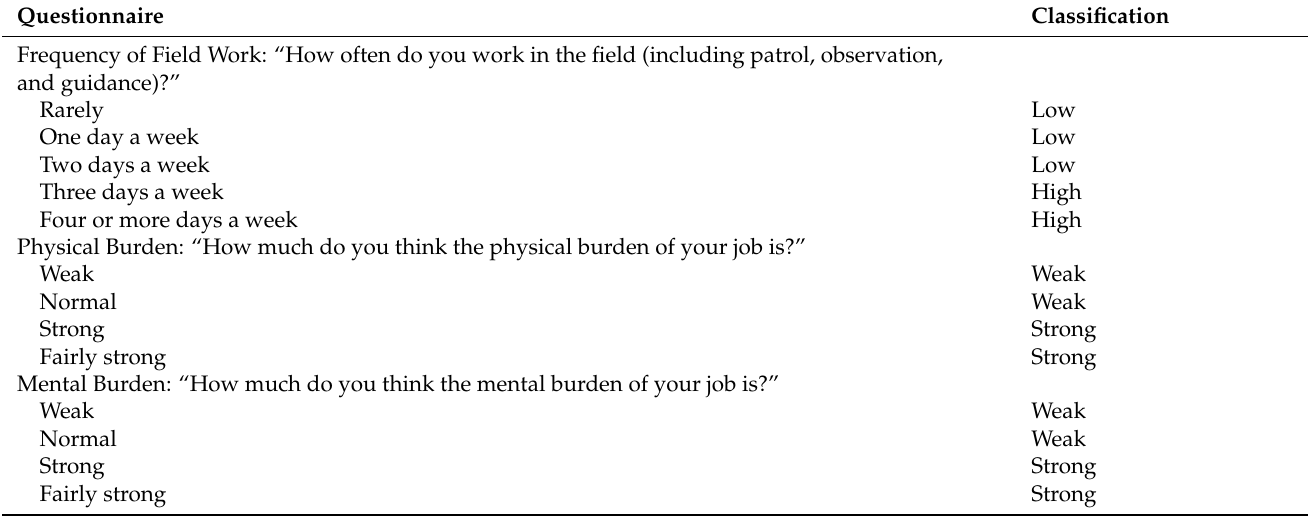
Table 1. Questionnaire and